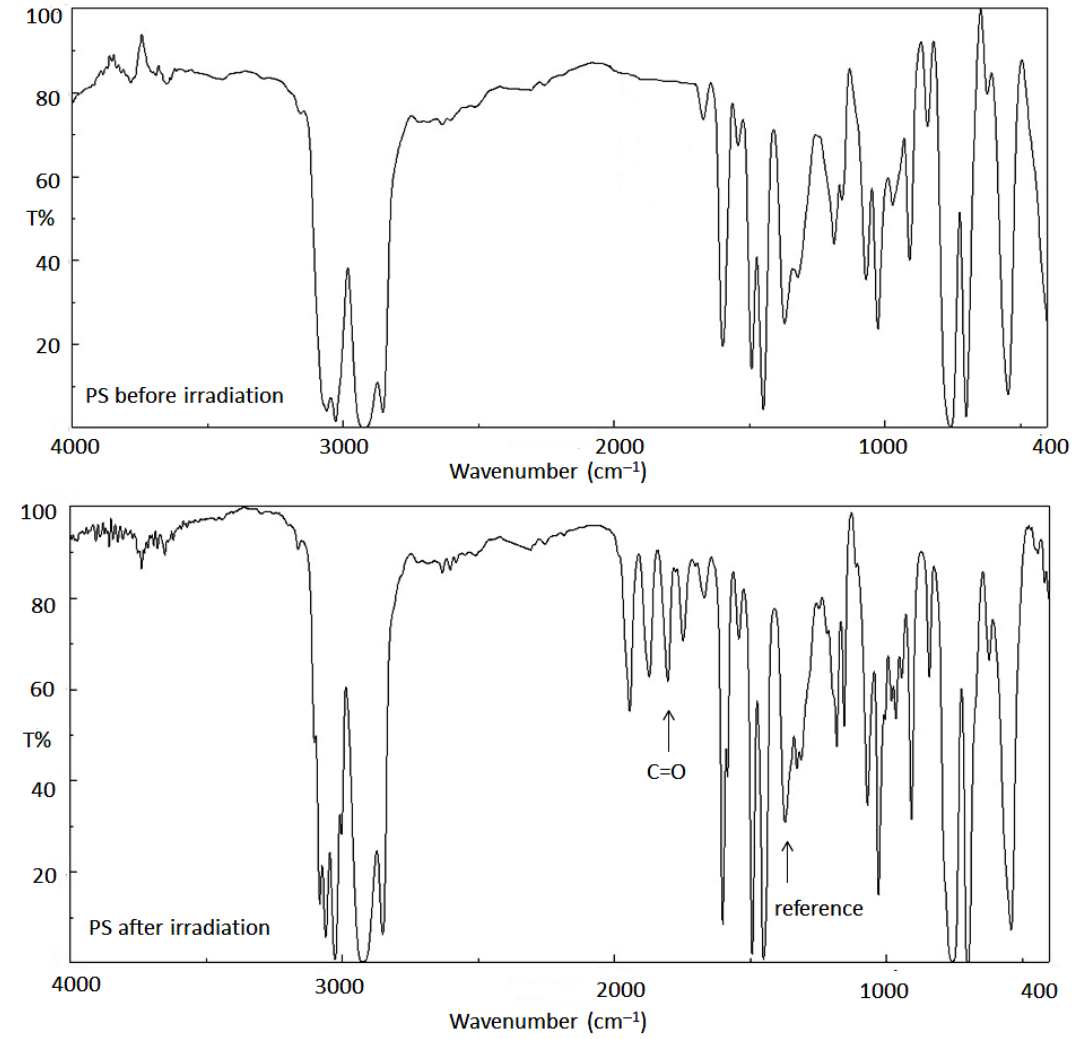
Figure 3. FT-IR spectra of PS film [17].